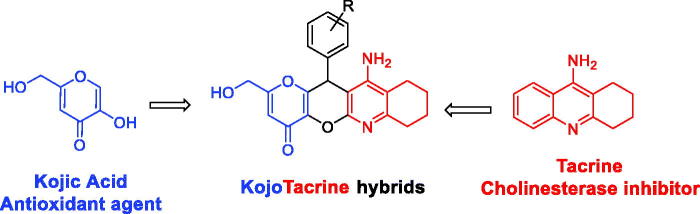

Figure 1. Design of KojoTacrine hybrids.